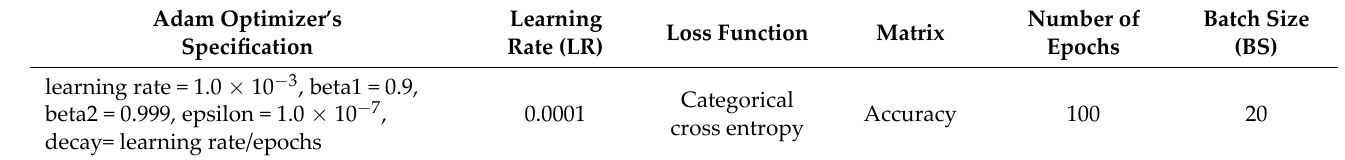
Table 3. Proposed model’s training parameters.